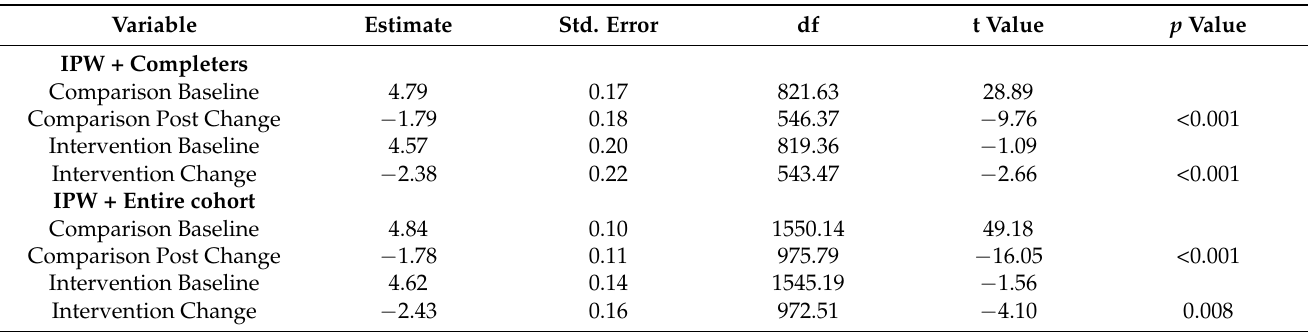
Table 2. Pain change analysis applying inverse probability weighting (IPW), considering either the entire cohort or just completers.